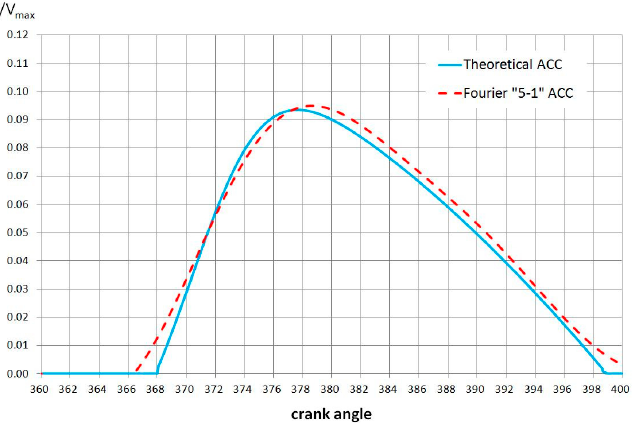
Figure 8. Comparison of volume changes in the complementary system, calculated analytically with those determined by five terms of the Fourier series for 1500 rpm, cr = 14:1.